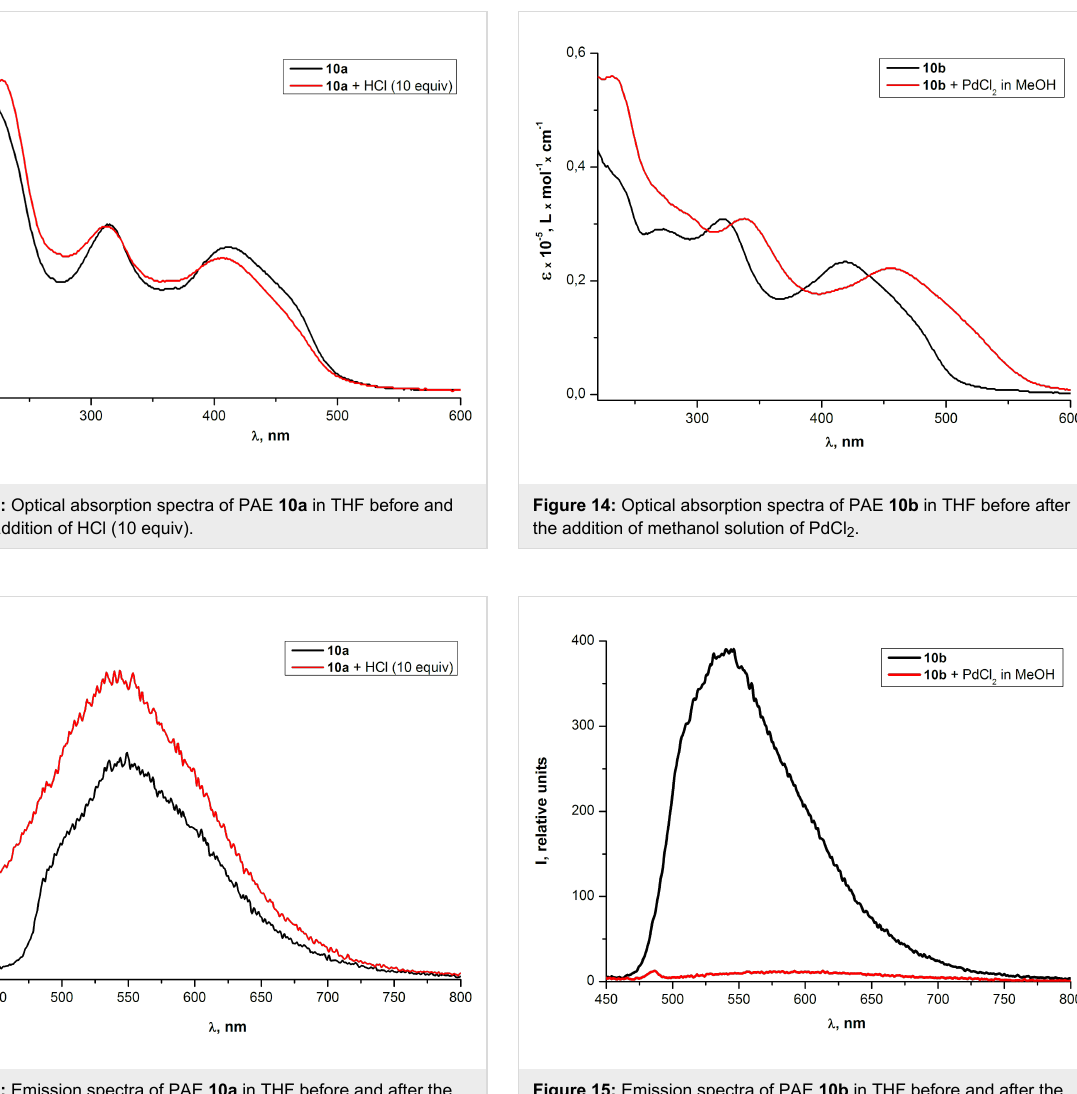
Figure 13: Emission spectra of PAE 10a in THF before and after the addition of HCl (10 equiv).